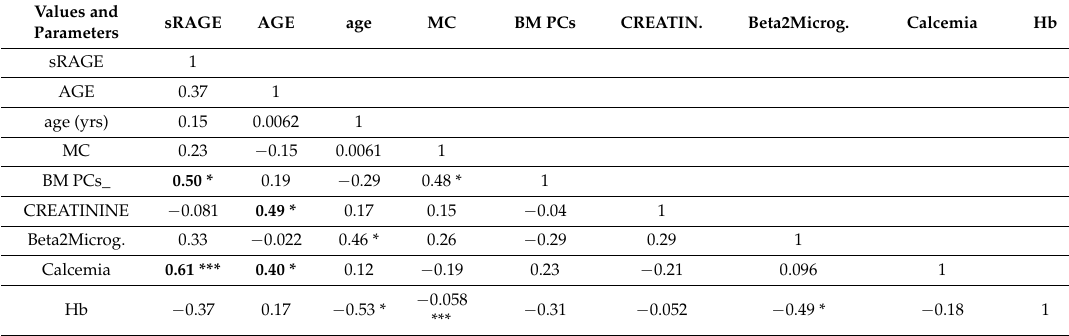
Table 1. Correlation between variables.